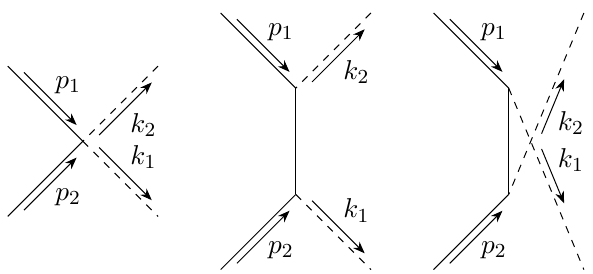
Figure 18 . Tree level Feynman diagrams describing the AA → BB scattering